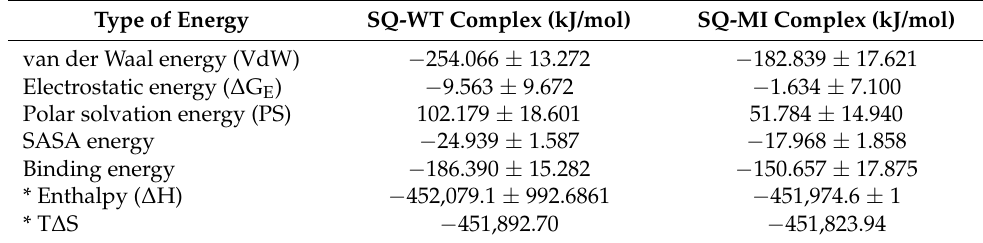
Figure 7. Binding free energy estimation of test complex. ( A ) Binding free energy plot of saquinavir- bound wild-type (blue color) and M46I-mutation-carrying protease (violet color). Decomposition of binding free energy per amino residue in saquinavir-bound ( B ) Wild-type and ( C ) M46I-mutation- carrying saquinavir-bound protease. Residue contribution plot of amino acid residues (< ± 1 kJ/mol) in ( D ) wild-type and ( E ) M46I-mutation-carrying saquinavir-bound protease. Table 1. Decomposition of binding free energy into its contributors in the test